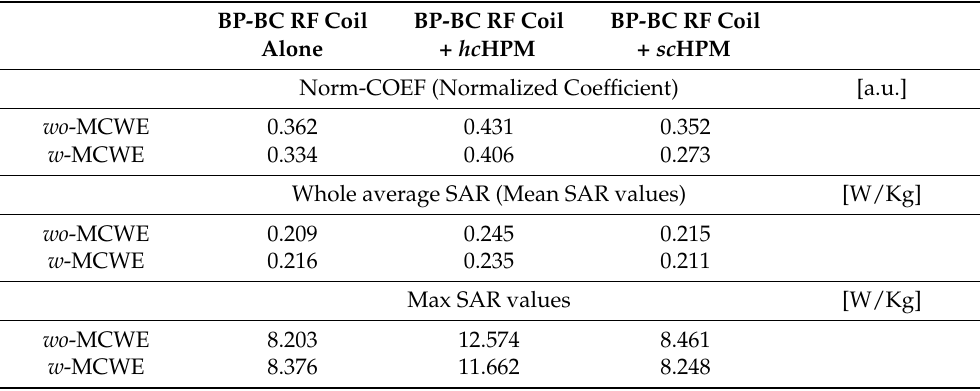
Table 2. Norm-COEF (Normalized coefficient), whole average SAR, and max SAR values of EM-field